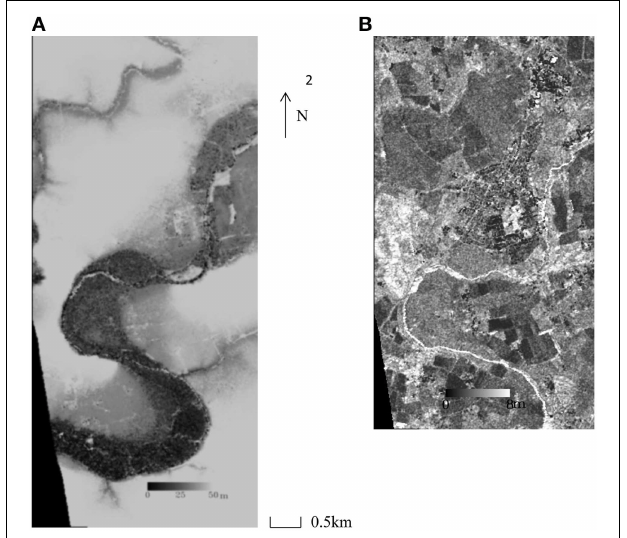
FIGURE 9 | (A) TanDEM-X IDEM of the flooded reach (a sub-area of Figure 1 ) and, (B) IDEM height error map of the flooded reach (lowest part not supplied) ( © DLR 2014) (after Mason et al., submitted).